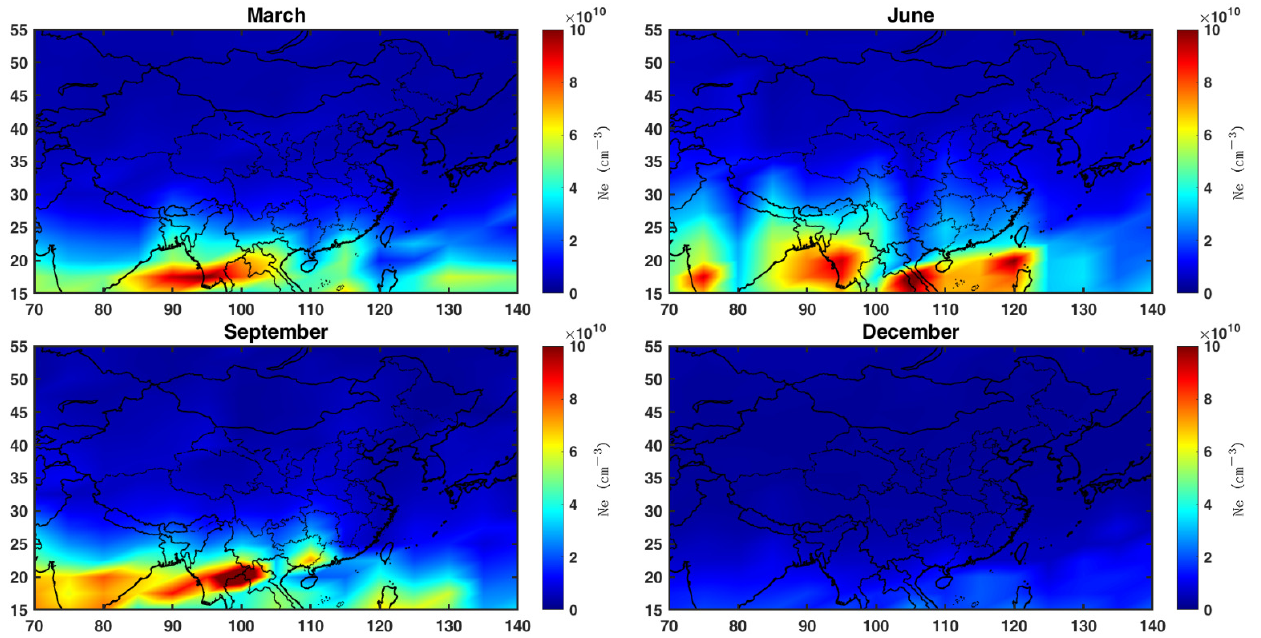
Figure 10. Spatial distribution of CSES Ne in different months for 2019.